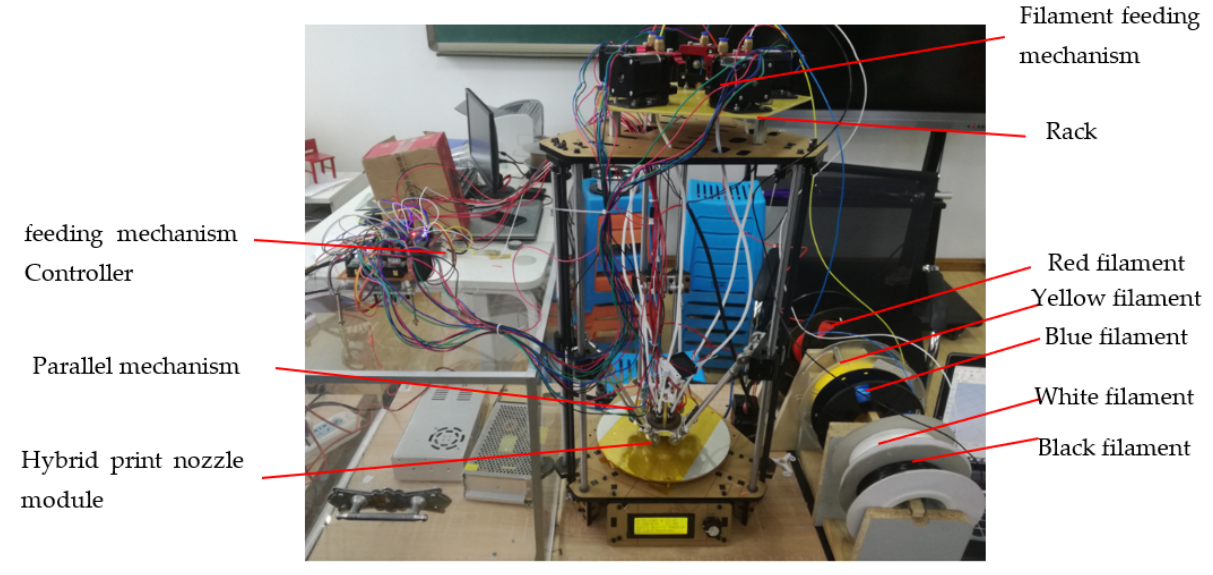
Figure 13. Color printing device.